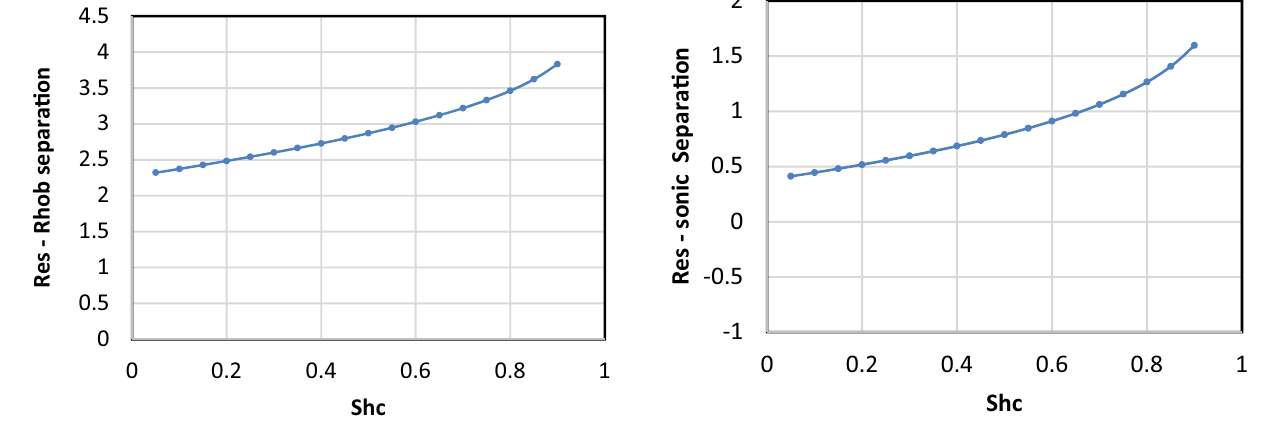
Fig. 23 S hc versus separation for